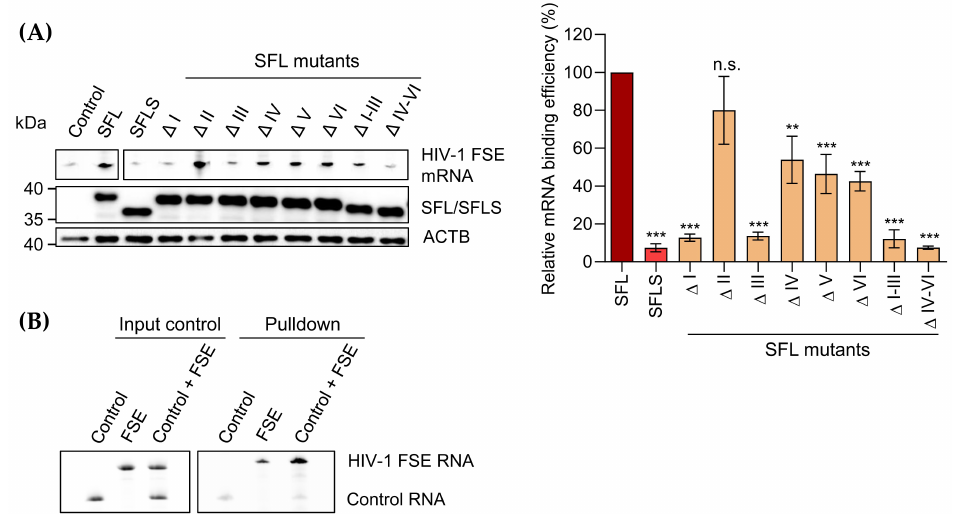
Figure 7. Deletions in the N-terminus of the RAA abrogate SFL binding to the HIV FSE. ( A ) HEK293T cells were transfected with plasmids encoding SFL, SFLS, or the indicated SFL mutants equipped with a C-terminal MYC-tag. A plasmid encoding GFP served as negative control. At 48 h post-transfection, the cells were lysed, fluorescence labeled HIV-1 FSE mRNA was added to cell lysates, and proteins were precipitated with anti-MYC antibody. Co-precipitated HIV-1 FSE mRNA was loaded on a urea gel and the subsequent fluorescence signal was quantified. Expression of SFL, SFLS, and SFLS mutants in WCL was confirmed via immunoblot using anti-MYC antibody. β-Actin (ACTB) expression in WCL served as a loading control. A single representative blot is shown in the left panel; irrelevant lanes were excised. Three biological replicates were quantified by the software ImageJ (right panel). SFL, SFLS, or SFL mutants were normalized to ACTB and in turn used for normalization of HIV-1 FSE mRNA signals. RNA signal measured upon precipitation of SFL was set as 100%. The average of three independent experiments is shown; error bars indicate the standard error of the mean (SEM). One-way analysis of variance (ANOVA) with Dunnett’s multiple comparison test was performed to determine whether differences between cells expressing SFL and SFLS or SFL mutants were statistically significant (not significant [n.s.]; **, p ≤ 0.01; ***, p ≤ 0.001; n = 3). ( B ) HEK293T cells were transfected with plasmid encoding SFL with a C-terminal MYC antigenic tag and WCL were prepared. Subsequently, WCL were incubated with an equimolar mixture of fluorescently tagged HIV-1 FSE mRNA and a control mRNA containing multiple secondary structures. Competitive protein–RNA binding was analyzed via urea–PAGE as described above (right panel). Input control mRNA, HIV-1 FSE mRNA, and a mixture of both are shown in the left panel. The results of a representative experiment are presented and were confirmed in two independent experiments. SFL, shiftless wild type; SFLS, shiftless short; FSE, frameshifting stimulation element; WCL,